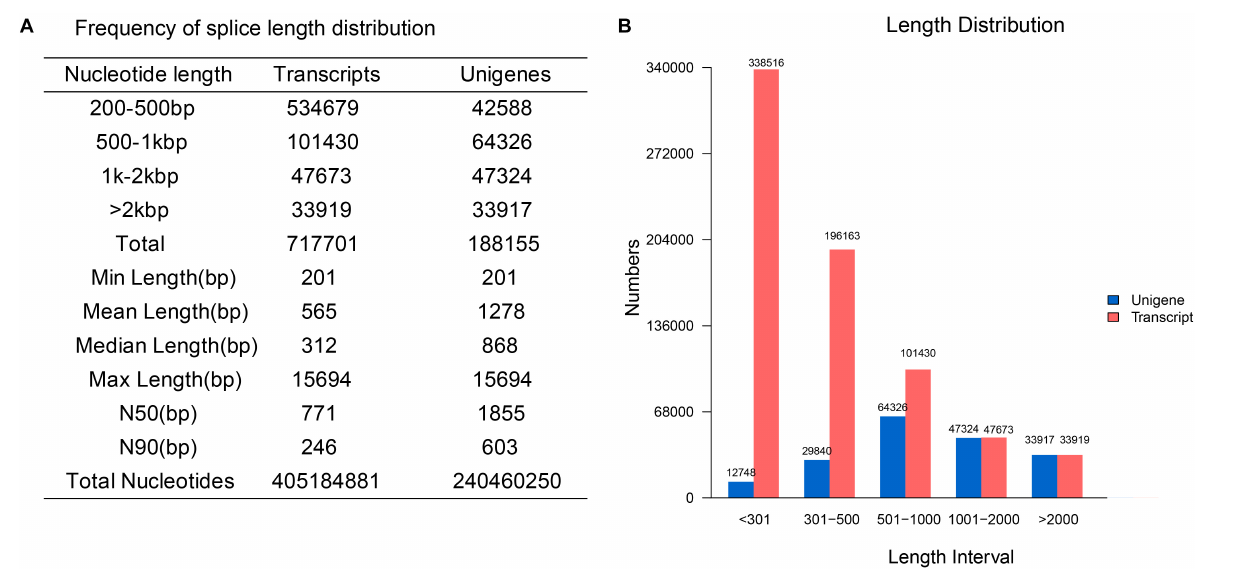
FIGURE 2 | The detailed statistics and distribution of transcripts and unigenes. (A) The statistics of transcripts and unigenes. (B) The length distribution of transcripts and